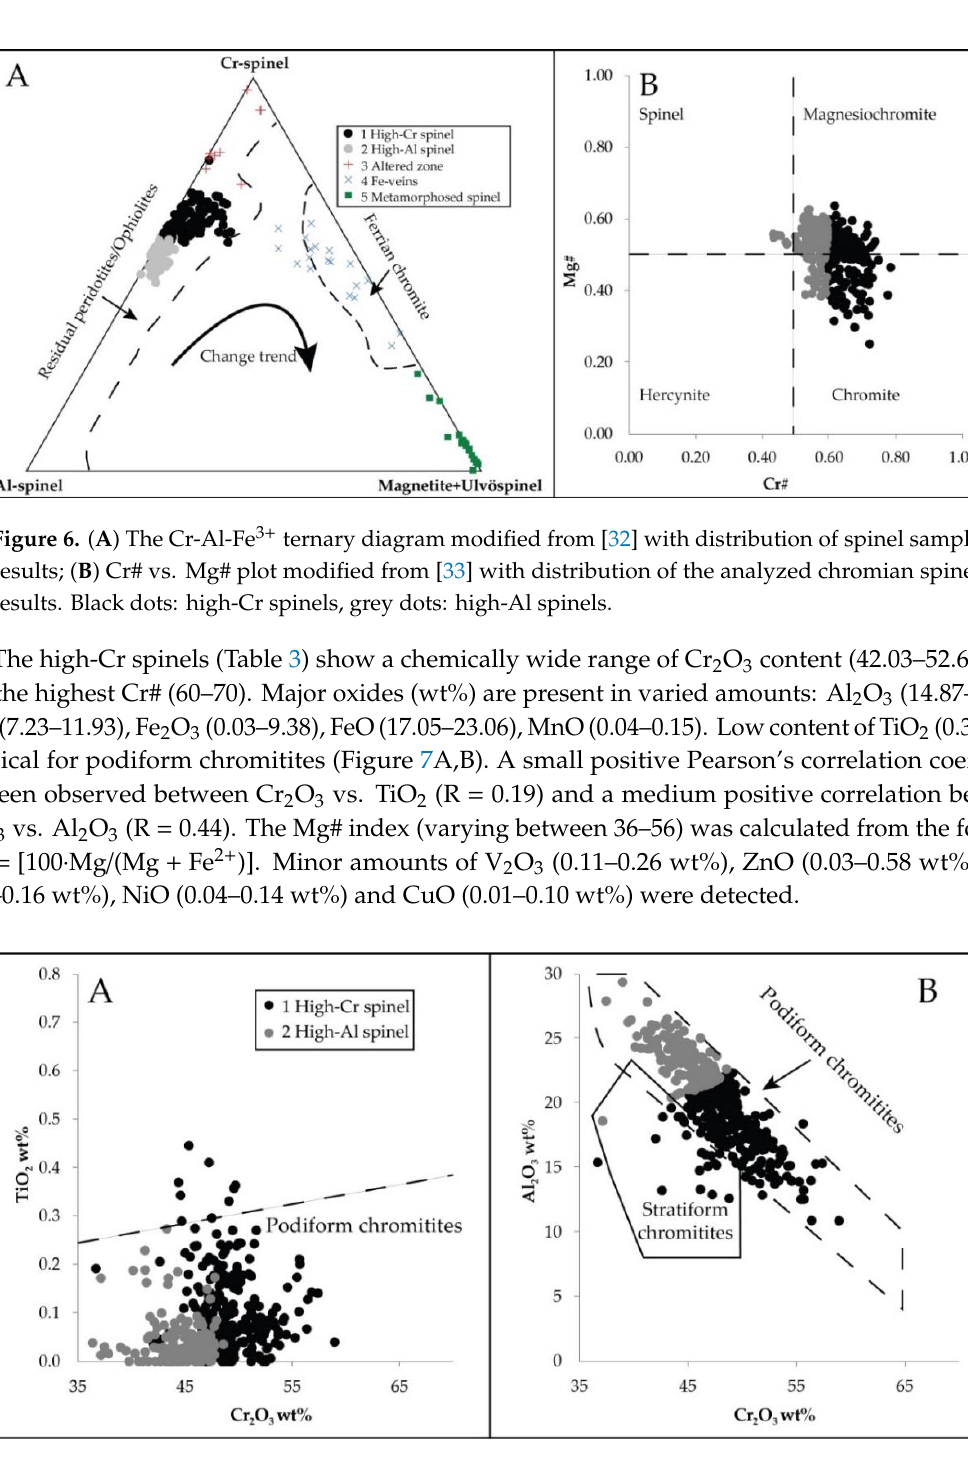
Figure 7. Chemical variations of investigated chromian spinels. ( A ) Cr 2 O 3 vs. TiO 2 ; ( B ) Cr 2 O 3 vs. Al 2 O 3 . Classification fields after [31]. Black dots: high-Cr spinels, grey dots: high-Al spinels.